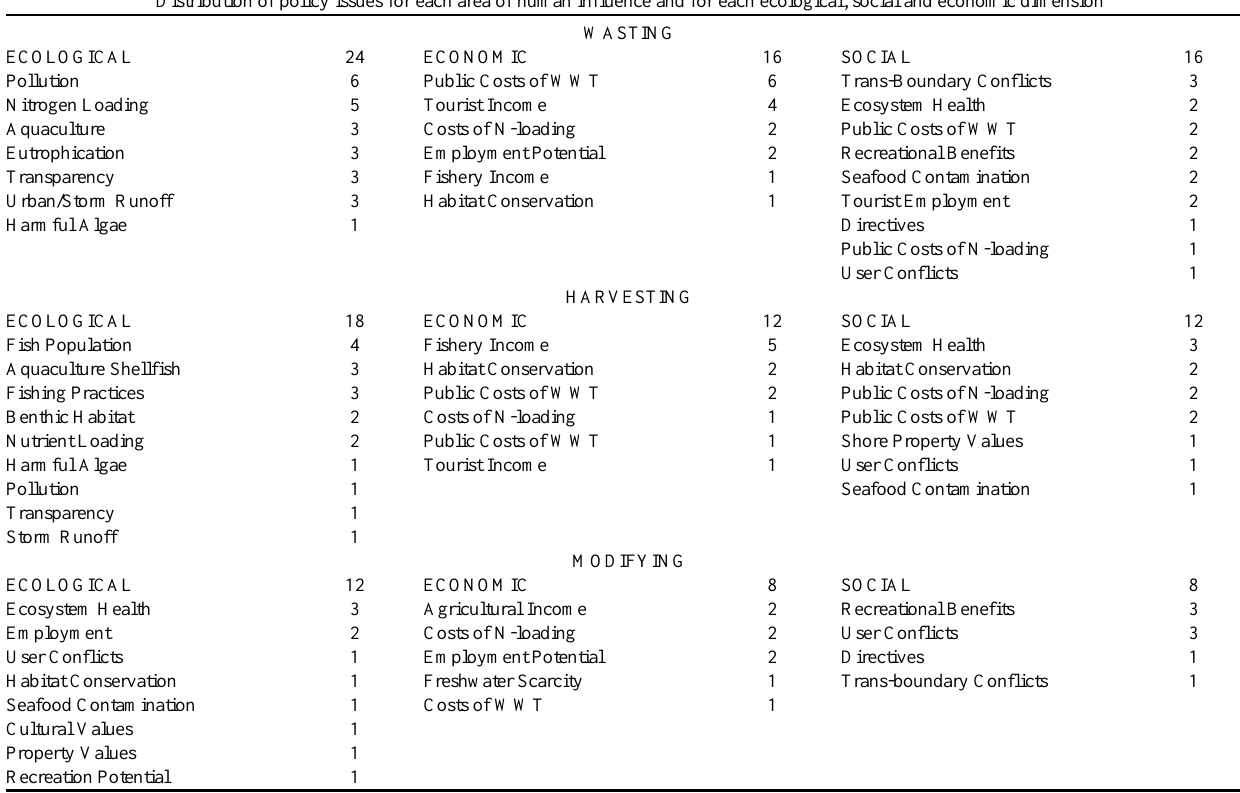
Table 3. Policy issues addressed by the 18 study sites (cf. Fig. 1), listed in the vertical panels according to the areas of human influence: wasting, harvesting, modifying, and conservation (see text). Each study site had at least three issues pertaining to the ecological component and two issues pertaining to each of the economic and social components (from Hopkins and Bailly 2012). None of the SSAs chose a primary policy issue related to conservation, although some had it as a secondary issue. WWT = Waste-Water Treatment, N = nitrogen Distribution of policy issues for each area of human influence and for each ecological, social and economic